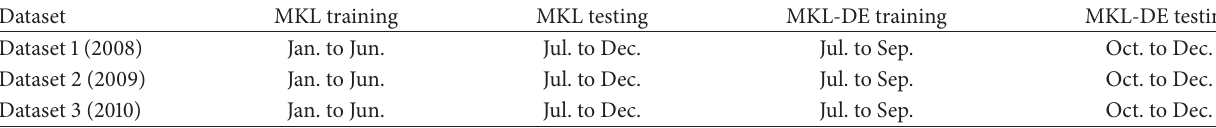
Table 7: Three datasets used for training and testing.